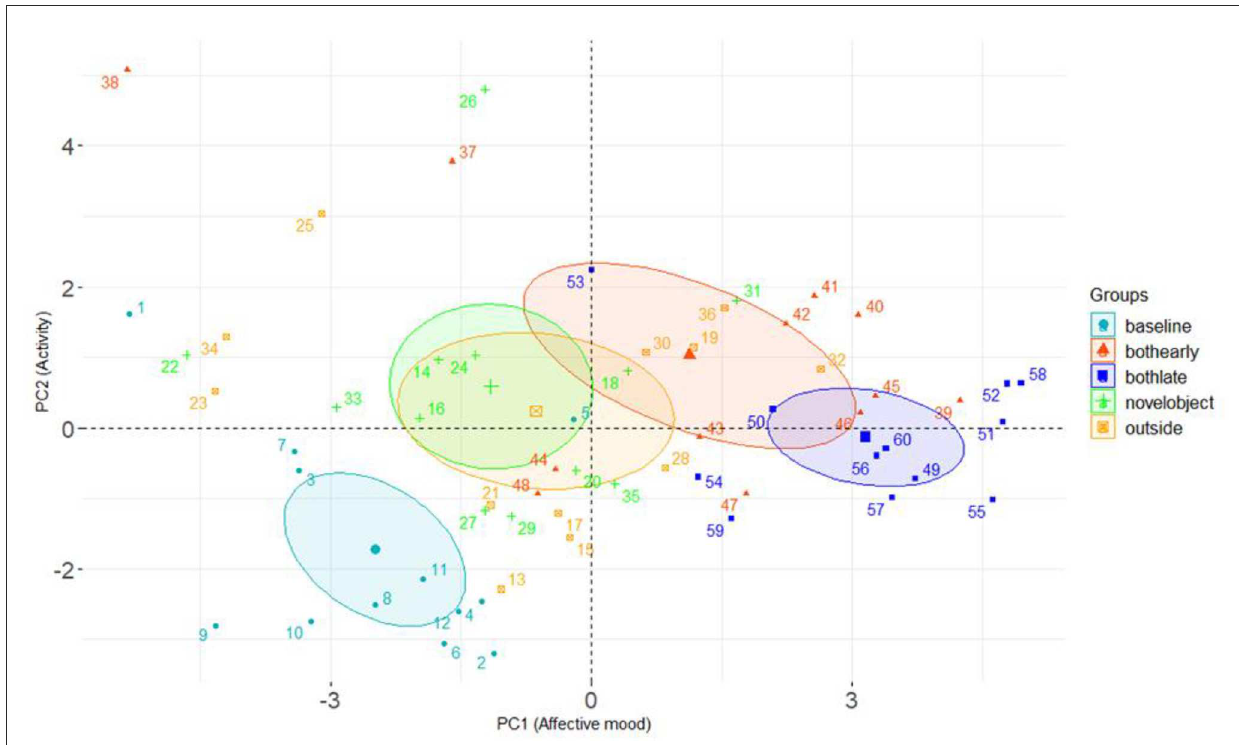
FIGURE9 Group 1 and 2 combined: Biplot displaying all QBA assessment scores in terms of PC1 and PC2. Each separate point displays one assessment date. Points are coded per treatment period [baseline, novel object, outside, both resources (early) and both (late)] as indicated on the plot. Group means are in bold and ellipses indicate the 95% confidence intervals of the group